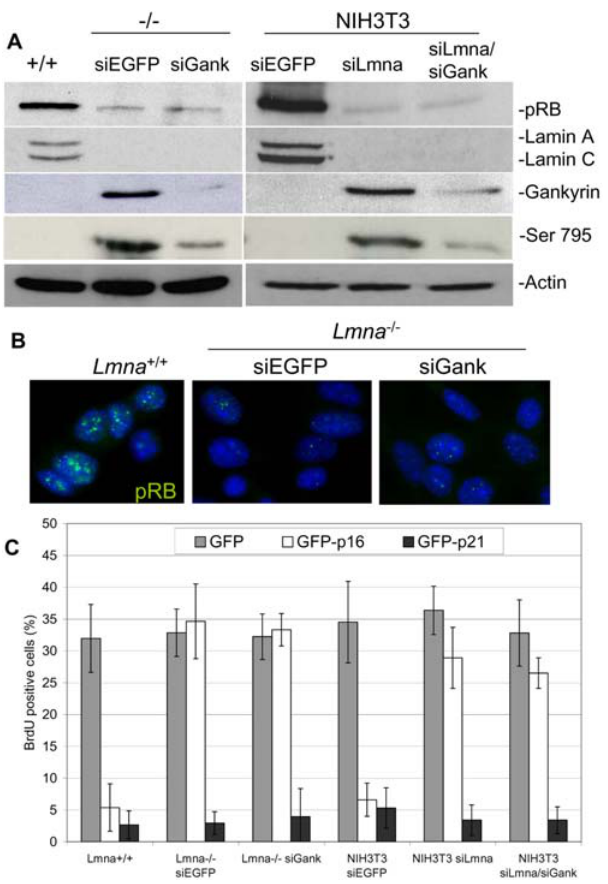
Figure 4. Reduction of gankyrin in cells lacking lamin A/C does not restore pRB or p16 ink4a sensitivity . Cells lacking lamin A/C ( Lmna 2 / 2 and NIH3T3 siLmna cells) were infected with siRNAs targeted to gankyrin (siGank) or siRNAs targeted to a control gene, enhanced GFP (siEGFP). (A) Western blot analysis comparing cells lacking lamin A/C and gankyrin ( Lmna 2 / 2 -siGank and siLmna/siGank) to cells only lacking lamin A/C. (B) Indirect immunofluorescence of Lmna 2 / 2 -siGank, Lmna 2 / 2 -siEGFP cells, and litter-mate control Lmna + / + cells. Images comparing the cells were collected using equal exposure times and image processing. (C) Cells were transfected with GFP-p16 ink4a or GFP- p21 cip1 and the S-phase cells were identified by BrdU incorporation. The percentage of cells positive for GFP and BrdU incorporation were quantified.